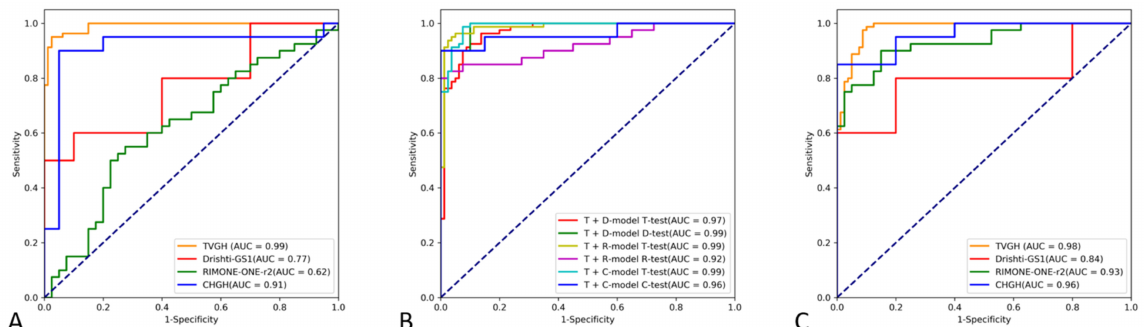
Figure 3. Receiver operating characteristic (ROC) curves of the TVGH model, dataset-specific models, and integrated model to differentiate between normal and glaucomatous fundus images on different test datasets. ( A ) The TVGH model is a CNN classifier constructed with the training images of the TVGH dataset. Different colored lines indicate the results obtained upon using the TVGH model to classify the test images of the TVGH, DRISHTI-GS1, RIM ONE r2, and CHGH datasets. ( B ) ROC curves of the dataset-specific models in predicting test images from the corresponding datasets. The line corresponding to the T + D model D test refers to the predictive result of DRISHTI-GS1-specific model trained with mixed training images from the TVGH and DRISHITI-GS1 datasets on DRISHTI- GS1 test images. T: TVGH; D: DRISHTI-GS1; R: RIM-ONE r2; C: CHGH. ( C ) ROC curves of the